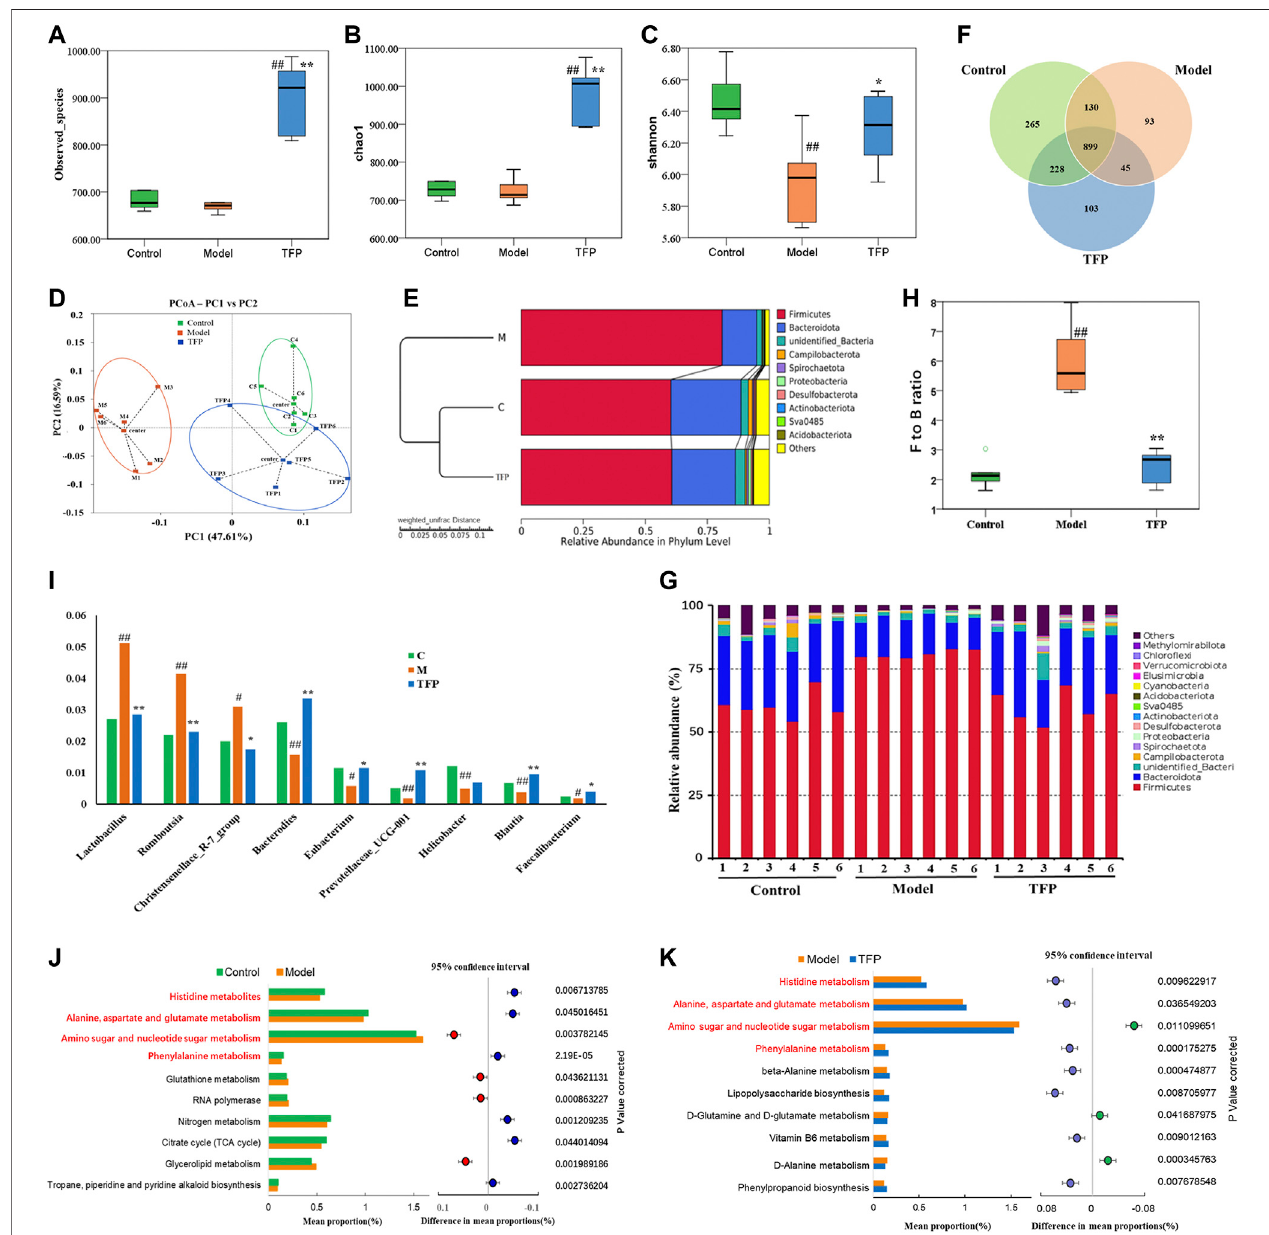
FIGURE 3 | TFP therapy affected the gut microbiota of RA model rats. (A,B) Chao1 index and Observed_species for each group, where TFP group signi fi cantly increased.Nosigni fi cantdifferencewasnotedbetweentheModelgroupandtheControlgroup. (C) TheShannonindexwassigni fi cantlylowerintheModelgroupthanin the Control group. No signi fi cant difference was noted between the TFP group and the Control group. (D) In terms of PCoA, the TFP group was closer to the Control group. (E) The hierarchical cluster tree showed that the TFP group had a more similar Beta diversity with the Control group. (F) Different numbers of OTUs are shownintheVenndiagram. (G,H) Atthephylumlevel,TFPloweredtheFirmicutestoBacteroidetes(FtoB)ratioofRAmodelrats. (I) TFPaffectedtherelativeabundance of Bacteroides, Eubacterium, Prevotellaceae_UCG-001, Blautia, Faecalibacterium, Lactobacillus, Romboutsia, and Christensenellace_R-7_group at the genus level in RA model rats. (J,K) Based on 16S rRNA sequencing data, the PICRUSt analysis was used to predict different metabolic pathways of TFP in RA. Control, Model, and TFP groups ( n = 6 per group).